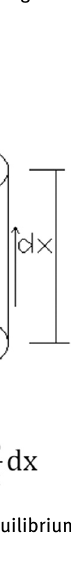
Figure 1: Change in apparent viscosity of low - thermal asphalt with temperature.